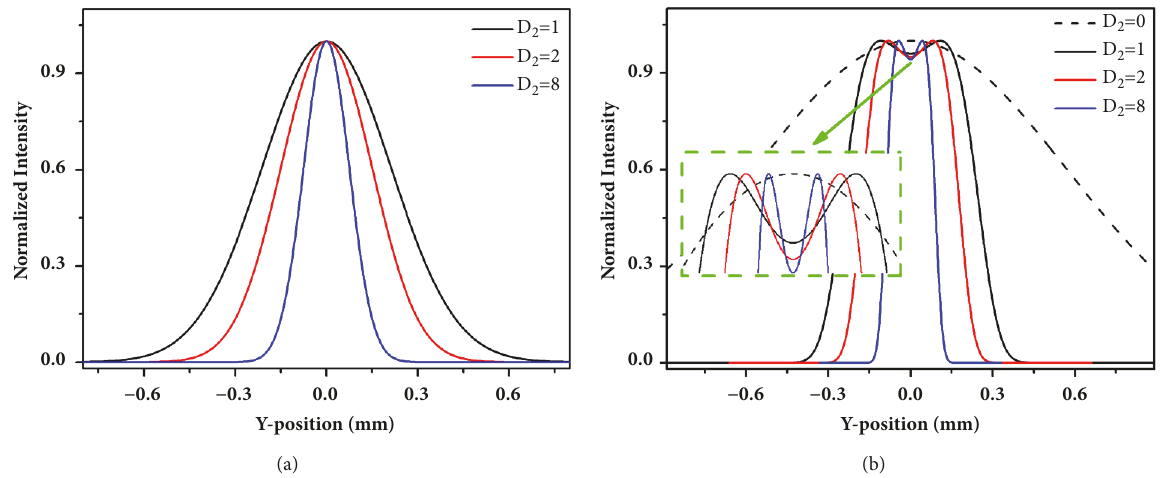
Figure 2: The corresponding cross line ( x =0) of (a) control lasers and (b) signal lasers when D 2 is